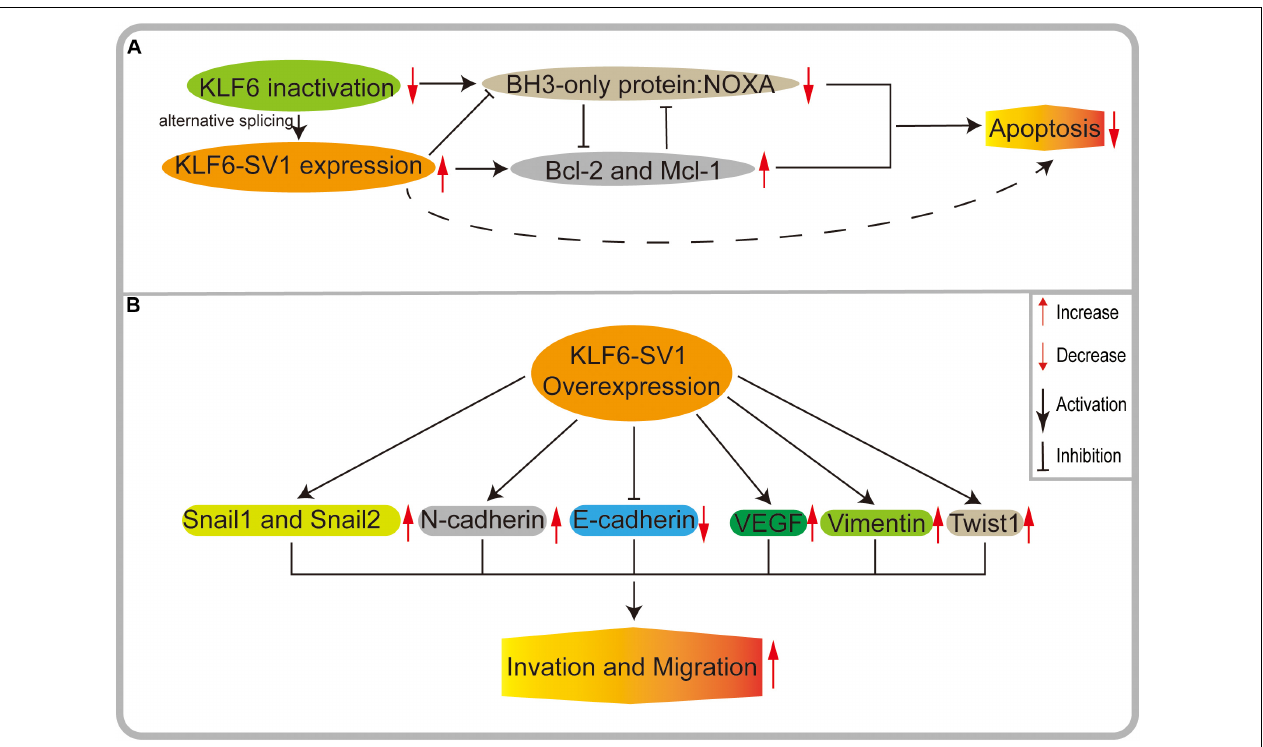
FIGURE 4 | (A) KLF6 produces oncogenic splicing KLF6-SV1 by increasing alternative splicing. KLF6-SV1 can bind to the pro-apoptotic BH3-only protein NOXA, resulting in the degradation of their mutual HDM2-dependent and accelerating the death of NOXA. High expression of KLF6-SV1 can increase the intracellular concentration of anti-apoptotic proteins McL-1 and BCL-2 and effectively prevent the apoptosis of cancer cells. (B) In KLF6-SV1 overexpressed tumor cells, E-cadherin expression is significantly decreased, while the expressions of VEGF, Twist1, N-cadherin, Vimentin, Snail1, and Snail2 are significantly increased, finally leading to tumor invasion and